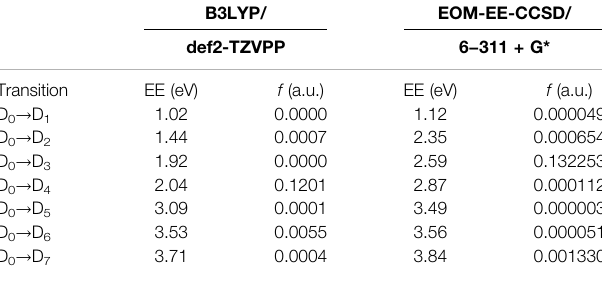
TABLE 2 | Excitation energies (EE) and oscillator strengths ( f ) for PNT + with a C – C – N – O dihedral angle of 87.4 ° at the B3LYP/def2-TZVPP and EOM-EE- CCSD/6-311+G* levels of